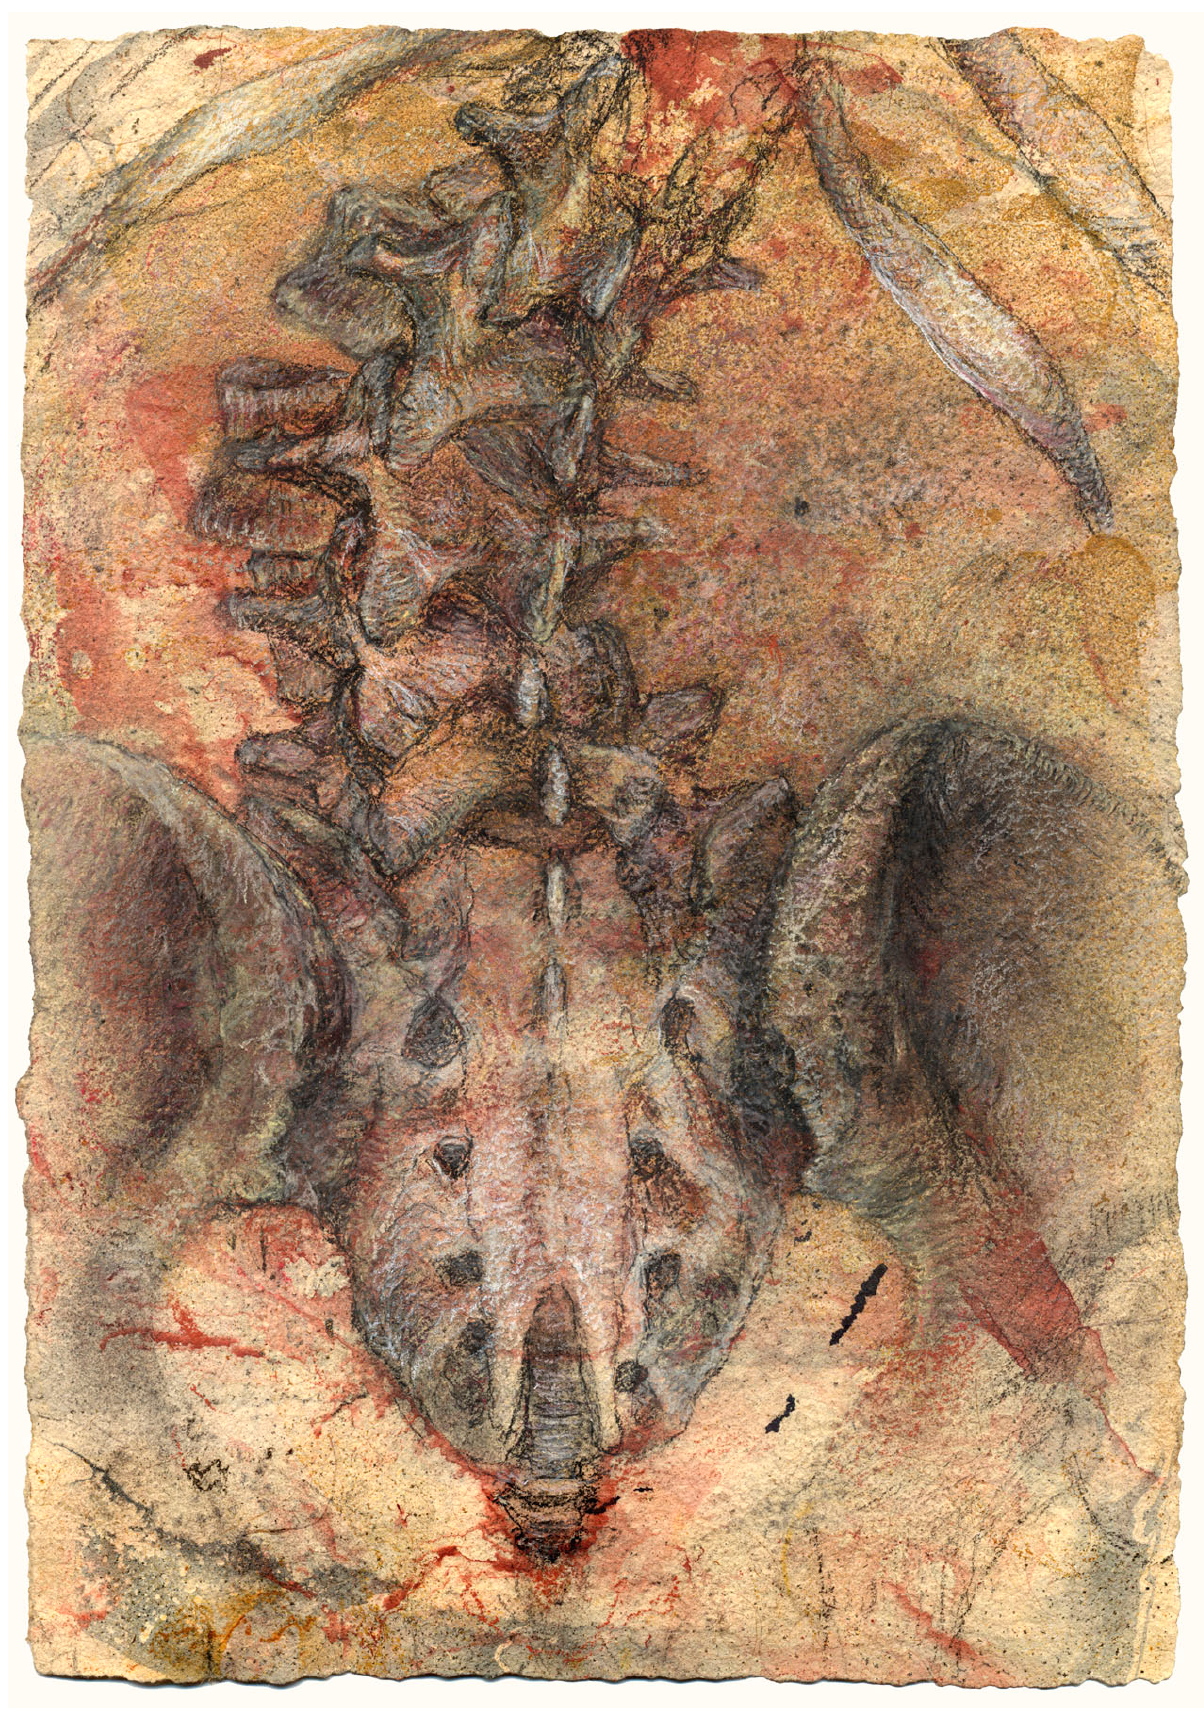
Figure 1 | Laura Ferguson, Lumbar vertebrae-sacrum posterior view, 2000. Courtesy of the